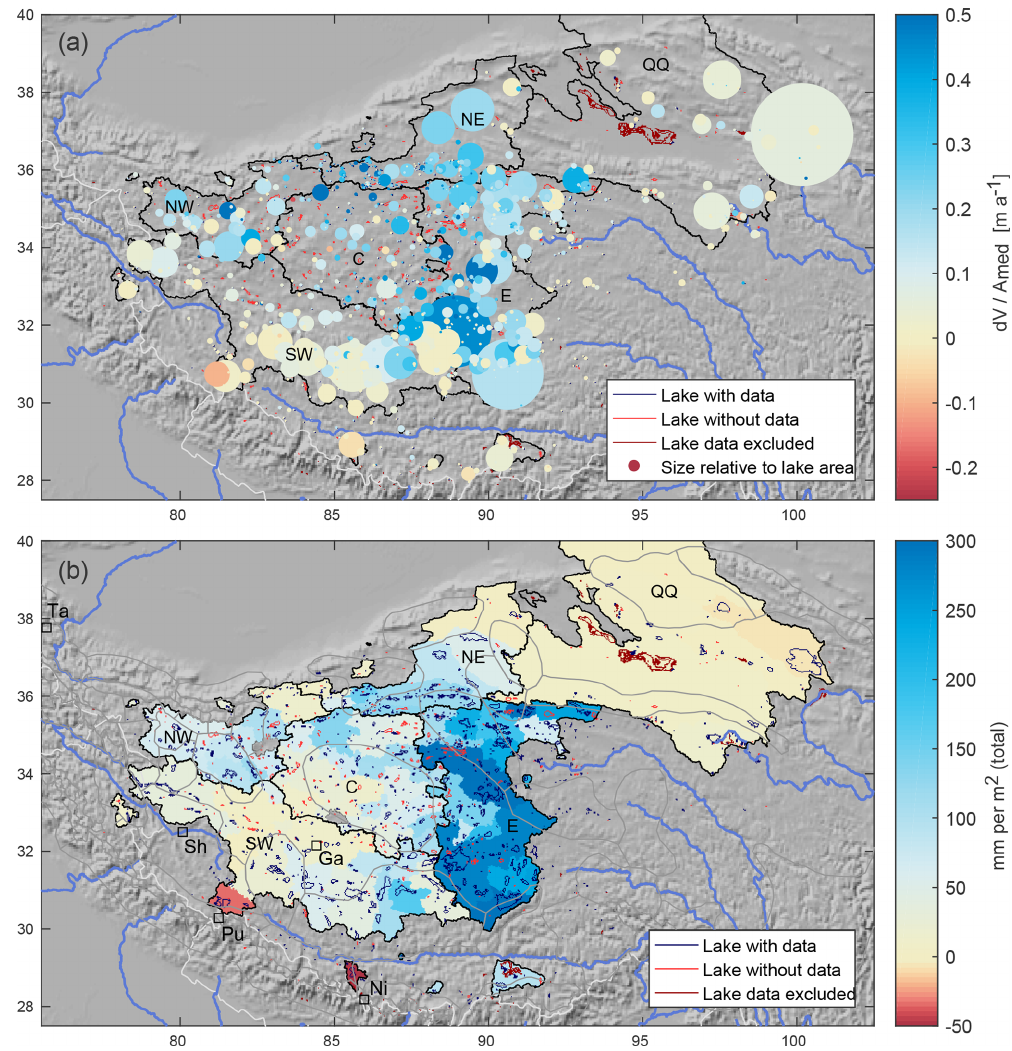
Figure 4. Lake volume changes on the Tibetan Plateau. (a) Normalised 1990–2015 lake volume change for individual lakes. Colours show the average annual 1990–2015 lake level change in metres (volume changes, dV, divided by median lake areas to receive comparable values for lakes of different sizes). Circle areas are scaled relative to lake areas. (b) Specific water change per endorheic catchment for the decadal difference between 1990–1999 and 2000–2009 lake volumes. Values correspond to the sum of individual lake water volume changes (average changes assumed for lakes with missing data) divided by catchment area to make their units comparable to precipitation sums. Red lake outlines: lacking plausible data; purple lake outlines: lakes excluded due to human influence on lake levels/extent. Squares: meteorological stations. Labelled regions with black outlines are referred to in the